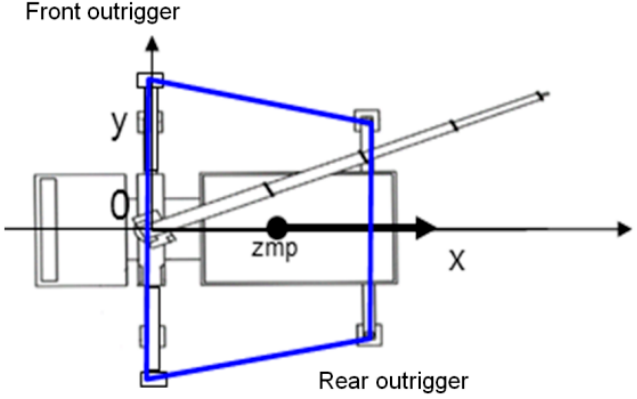
Figure 1. Schematic diagram of the stable area of a mobile crane.